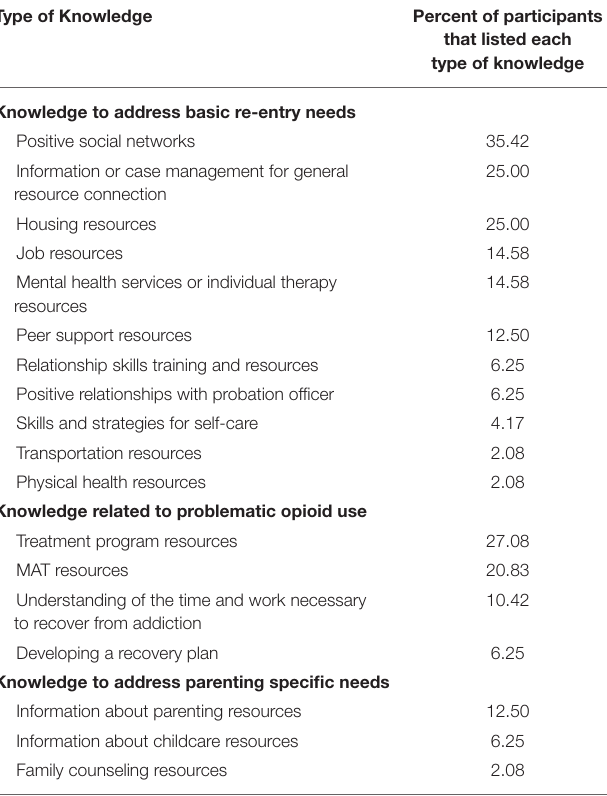
TABLE 3 | Needed knowledge for CIO